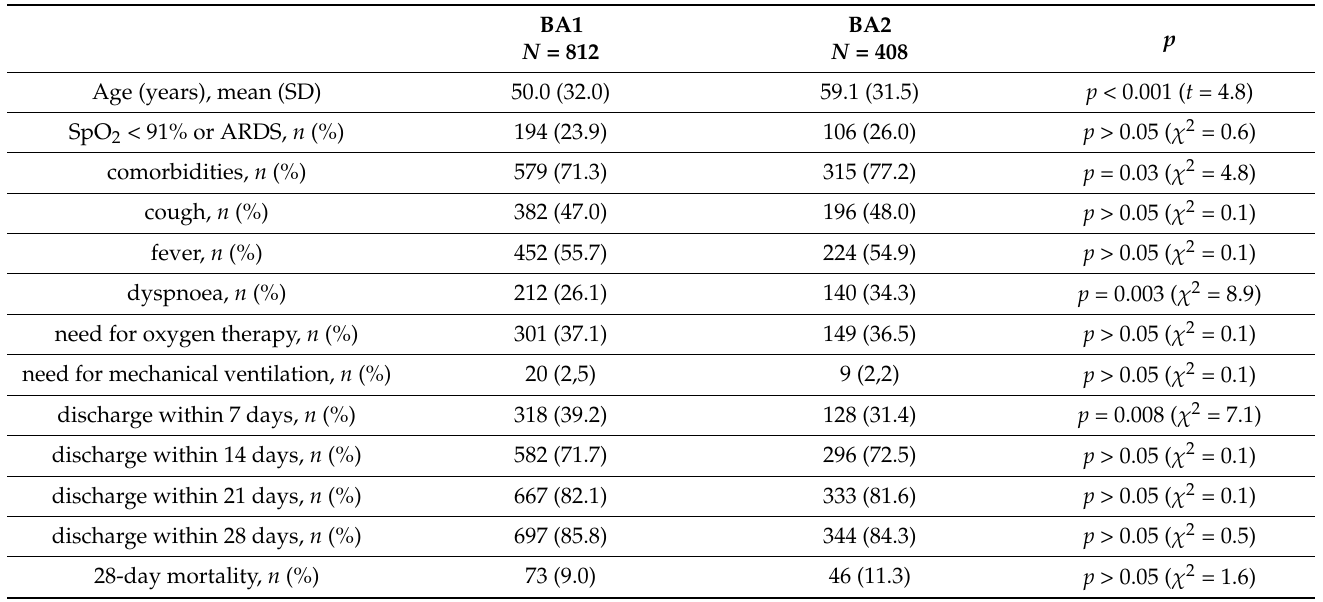
Table 5. Comparison of patients and disease characteristics during periods dominated by the BA1 and BA2 Omicron subvariants.